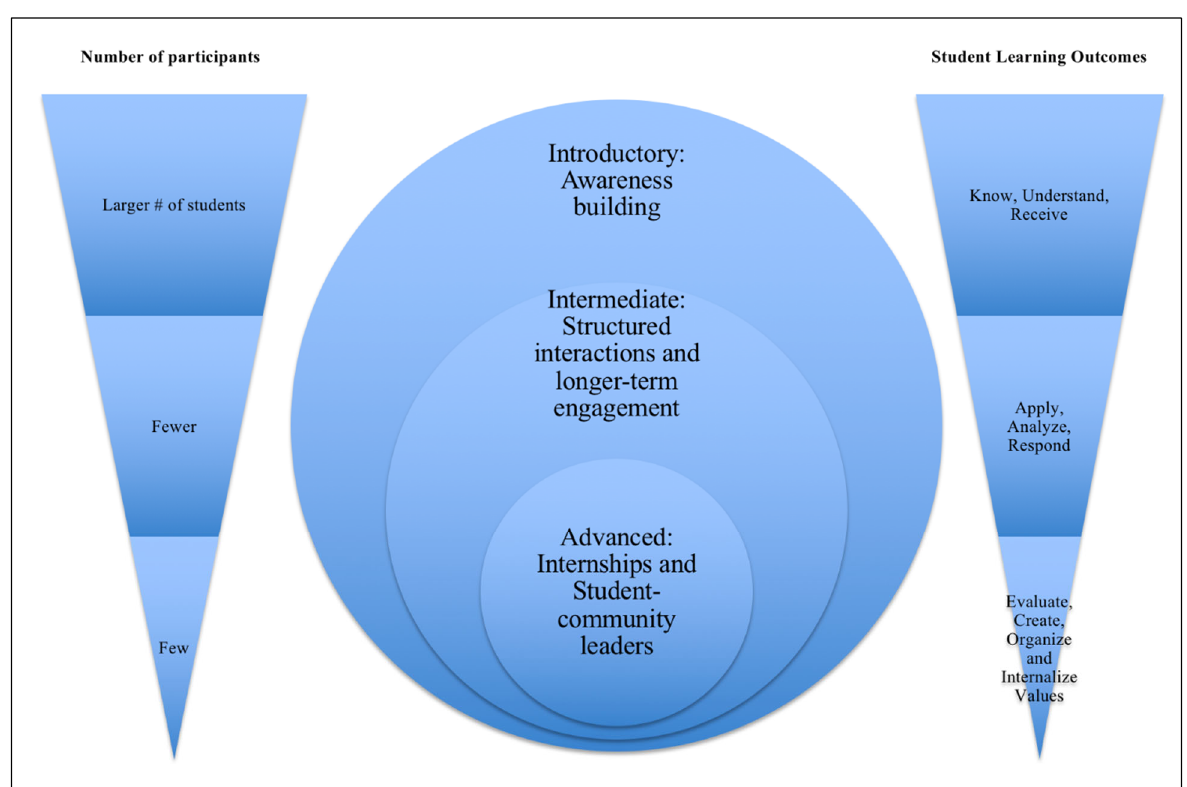
Figure 1. The Onion of Community-Student Engagement for Food